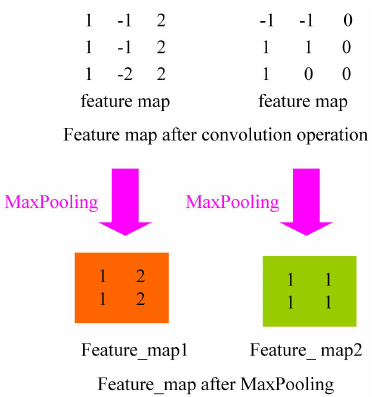
Figure 8. Image feature maximum pooling